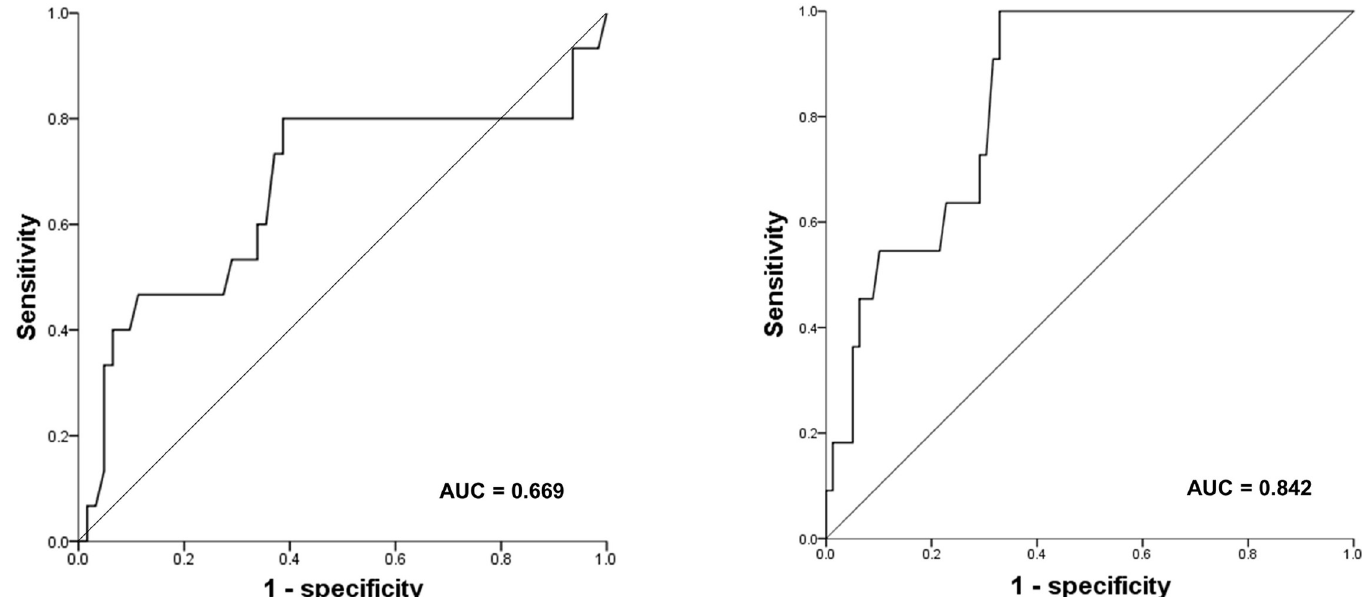
Fig 1. Receiver-operating characteristic curve analysis for the lymph node ratio predicting survival (A) and recurrence (B).